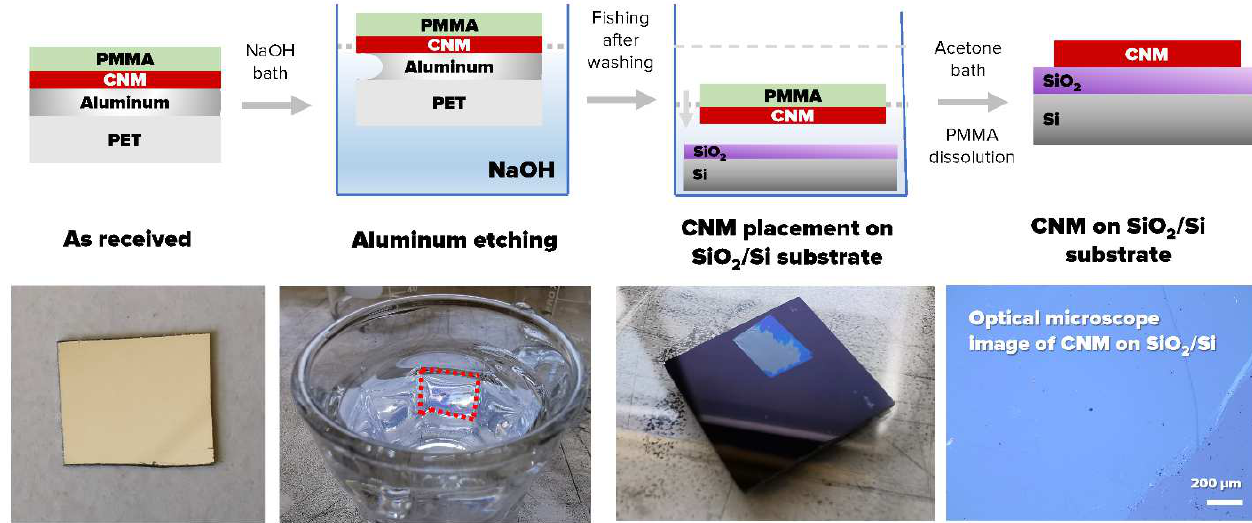
Figure 1. The transferring process of NBPS-CNM from Al/PET to Si.